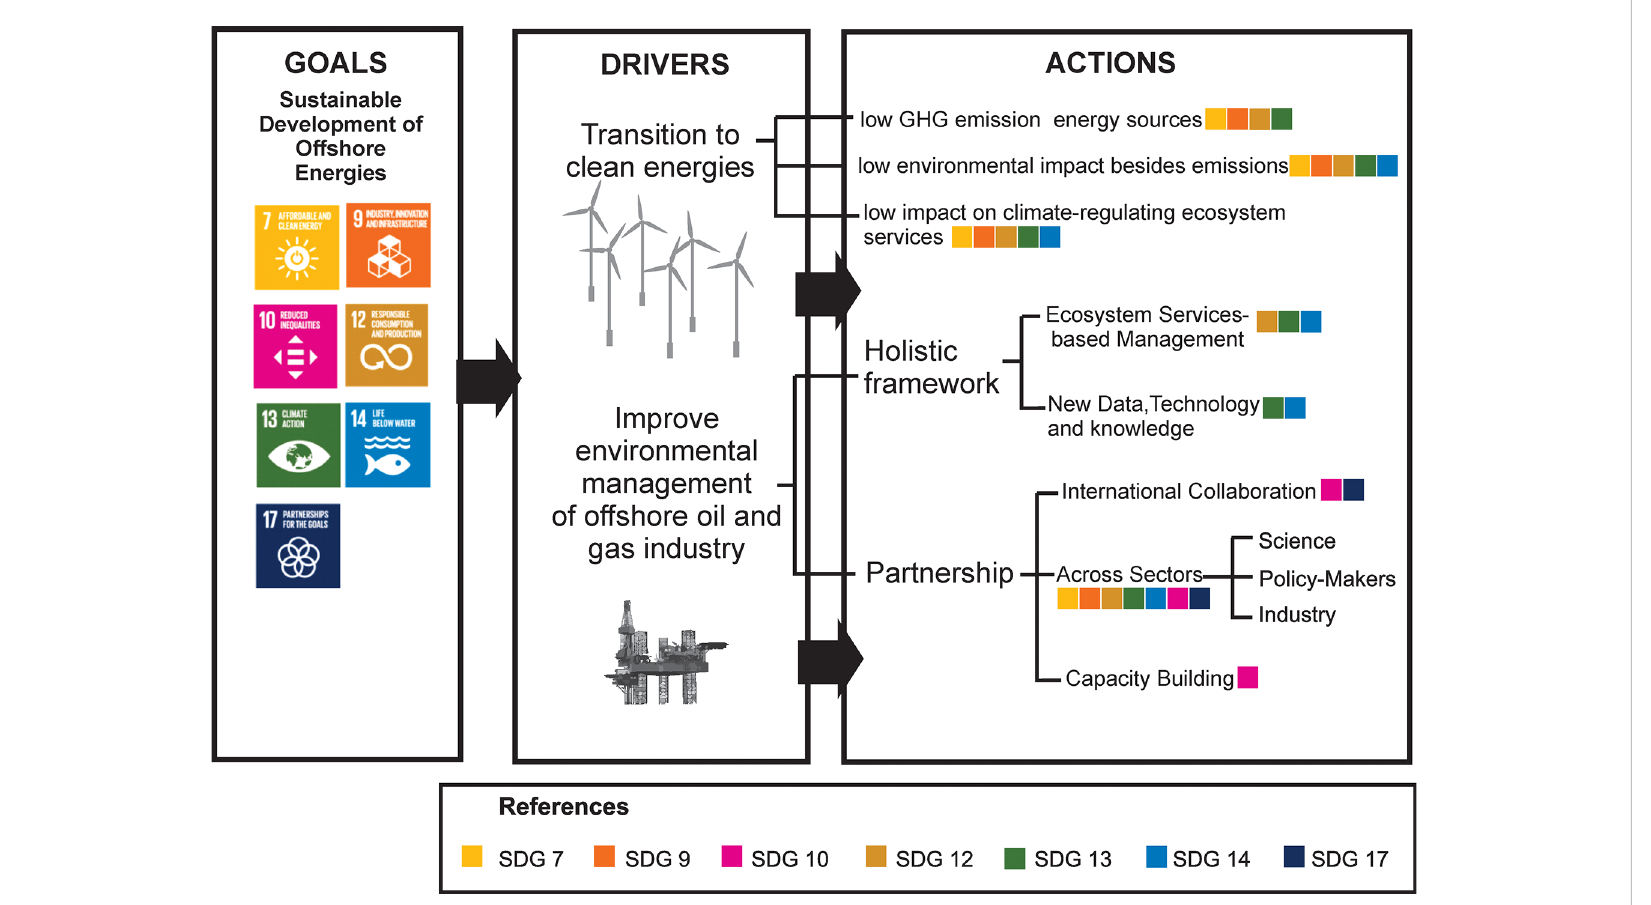
FIGURE 1 The sustainable development of offshore energy industries framed onto the United Nations Sustainable Development Goals (SDGs). We propose two main drivers and examples of speci fi c actions that can play key roles meeting some SDGs. The SDGs that can be met by each action (illustrated by their respective colors in the squares) are SDG 7, “ Clean and affordable energy ” ; SDG 9, “ Industry innovation and infrastructure ” ; SDG 10, “ Reduced inequalities ” ; SDG 12, “ Responsible consumption ” ; SDG 13, “ Climate action ” ; SDG 14, “ Life below water ” and SDG 17, “ Partnership for the goals ”